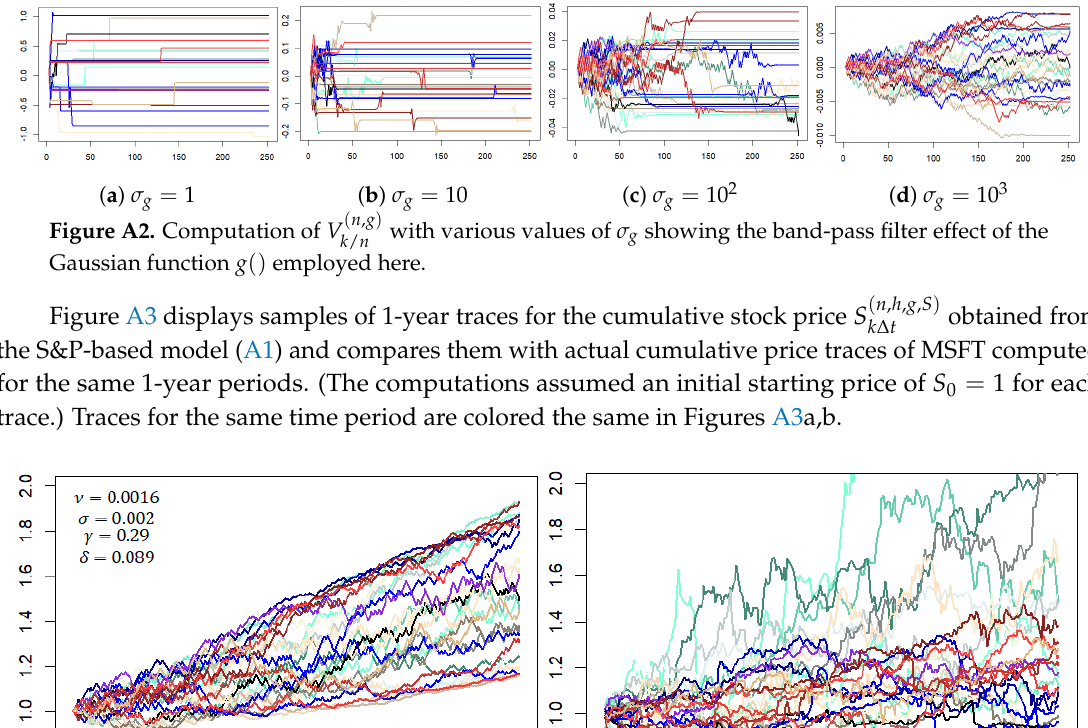
( n , h , g , S ) computed from (A1) based upon S&P 500 index k ∆ t